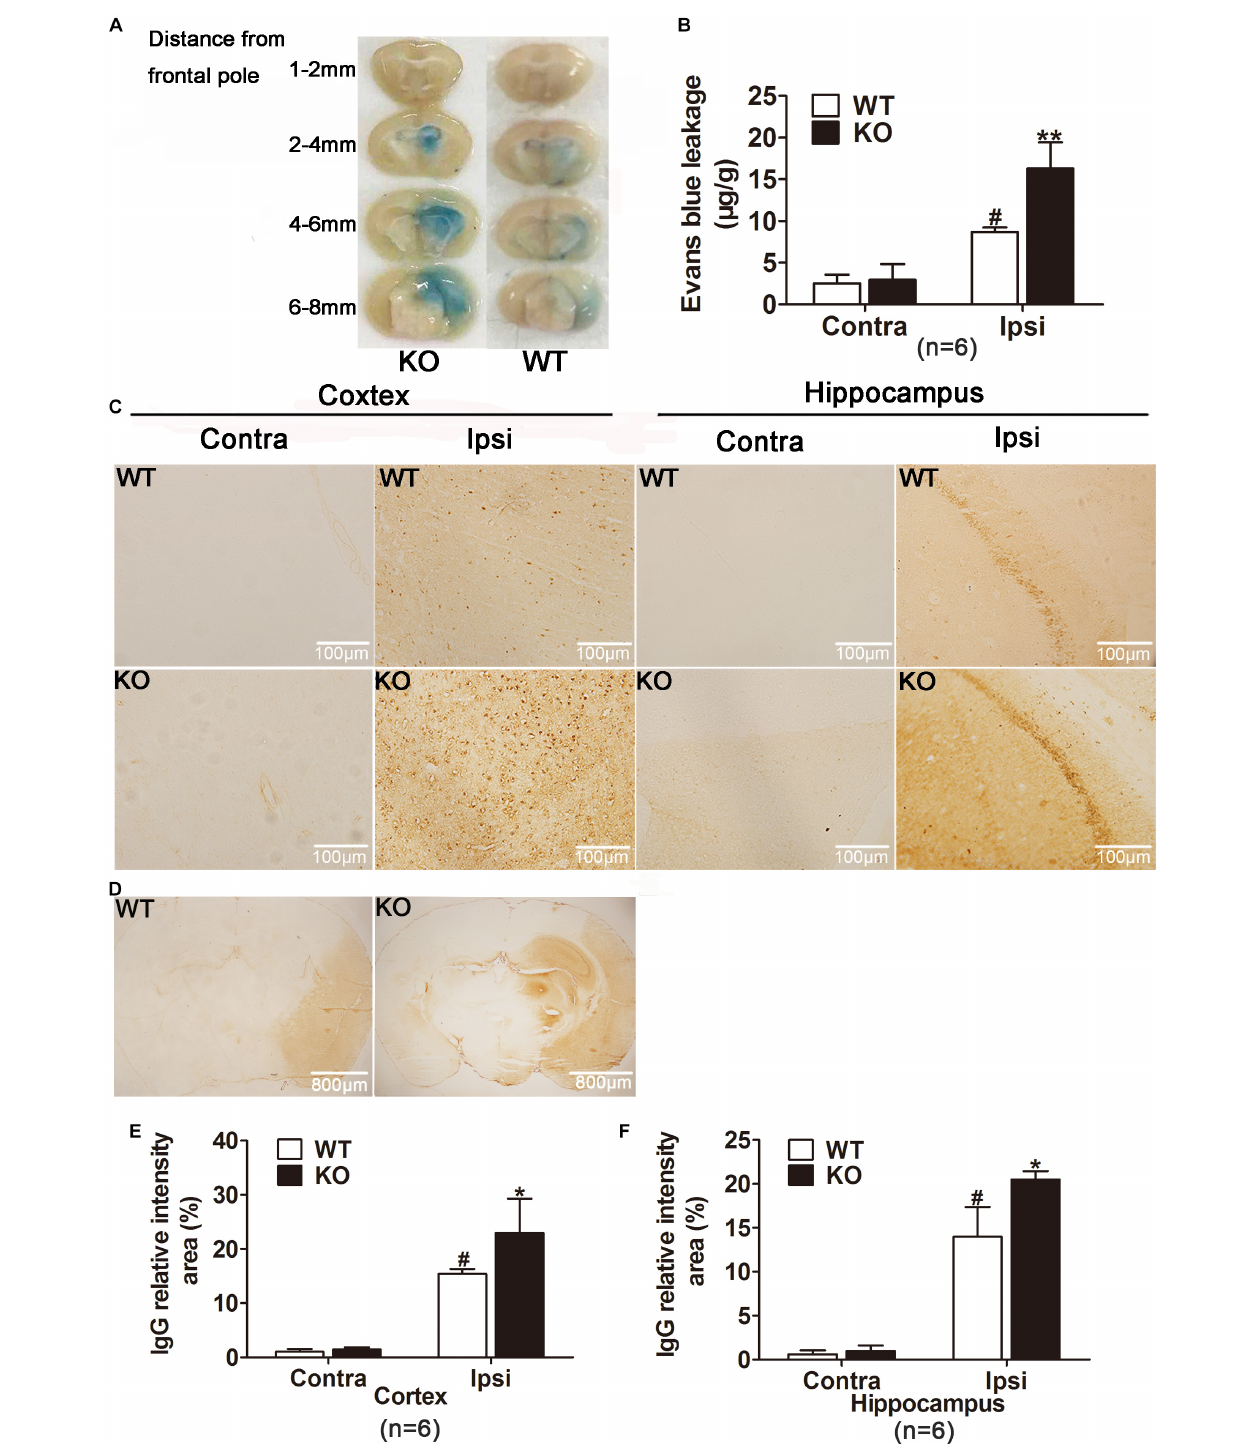
FIGURE 4 | IRAK-M deficiency accentuated the extent of blood–brain barrier (BBB) leakage in mice. (A, B) Photographs and quantification of Evans blue extravasation are shown. Evans blue staining reveals an increase in the extent of BBB disruption in KO mice 24 h after reperfusion compared with that in WT mice. (C) Representative photomicrographs of IgG leakage in hippocampus and cortex at 24 h after reperfusion, respectively. Bar, 100 µ m. (D) Representative microscopic images of brain sections after IgG staining. Bar, 800 µ m. (E) The IgG relatively intensity was calculated with ImageJ and presented in the bar graphs. Data are expressed as mean ± SD, n = 6 per group. ∗ P < 0.05, ∗∗ P < 0.01 vs. WT group, # P < 0.05 vs. sham group.